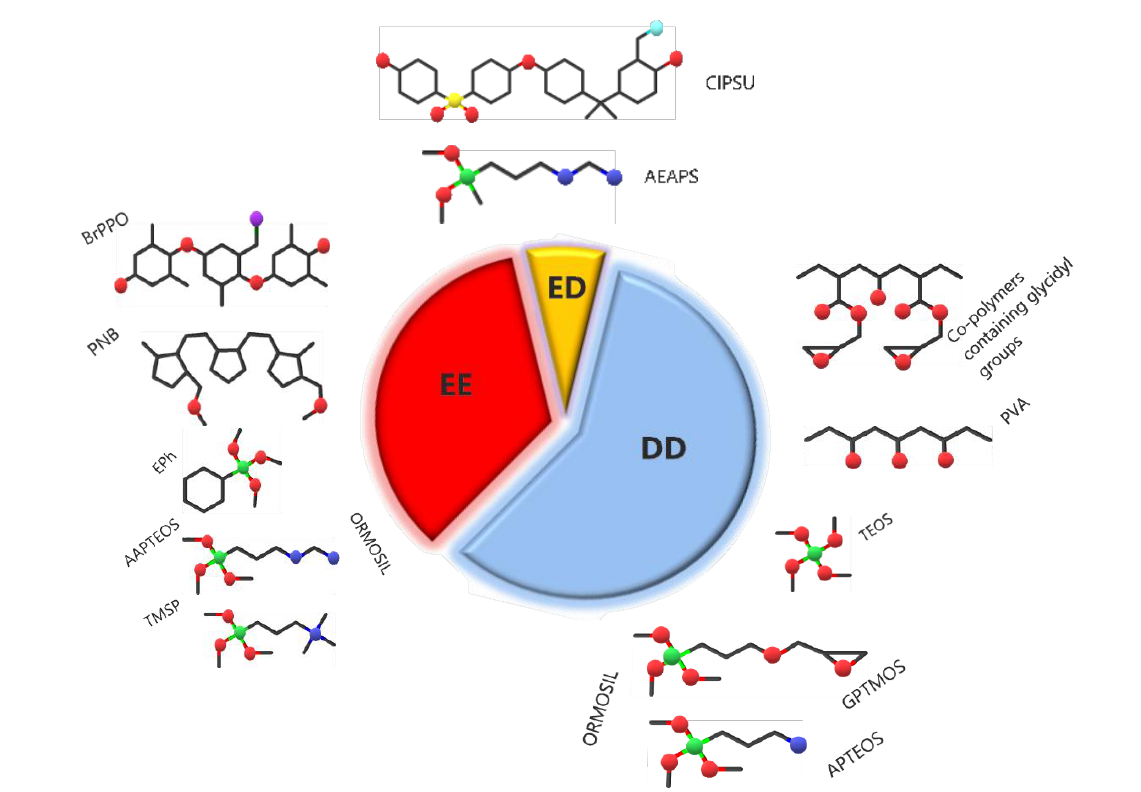
Figure 9. Relative amount of papers on the three main applications of sol–gel AEM and major polymer precursors and Si sources for these applications.